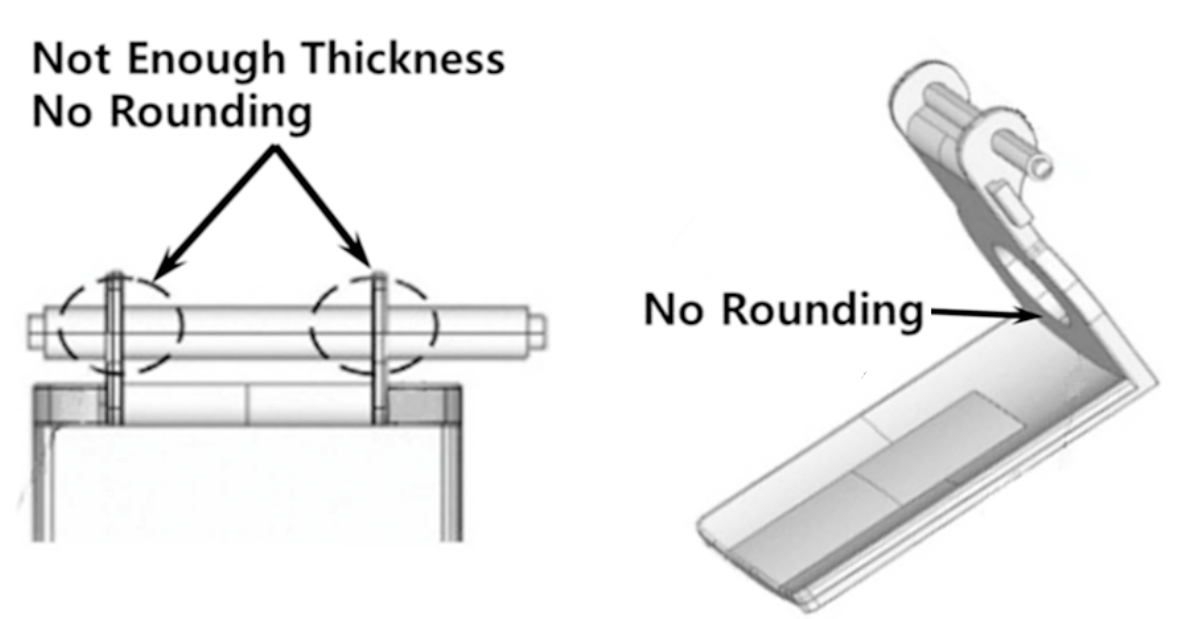
Figure 13. Structure of problematic lever in the field and ALTs.